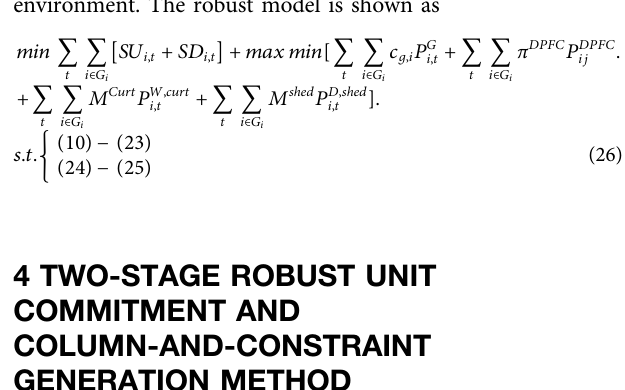
FIGURE 5 | Comparison of voltage.